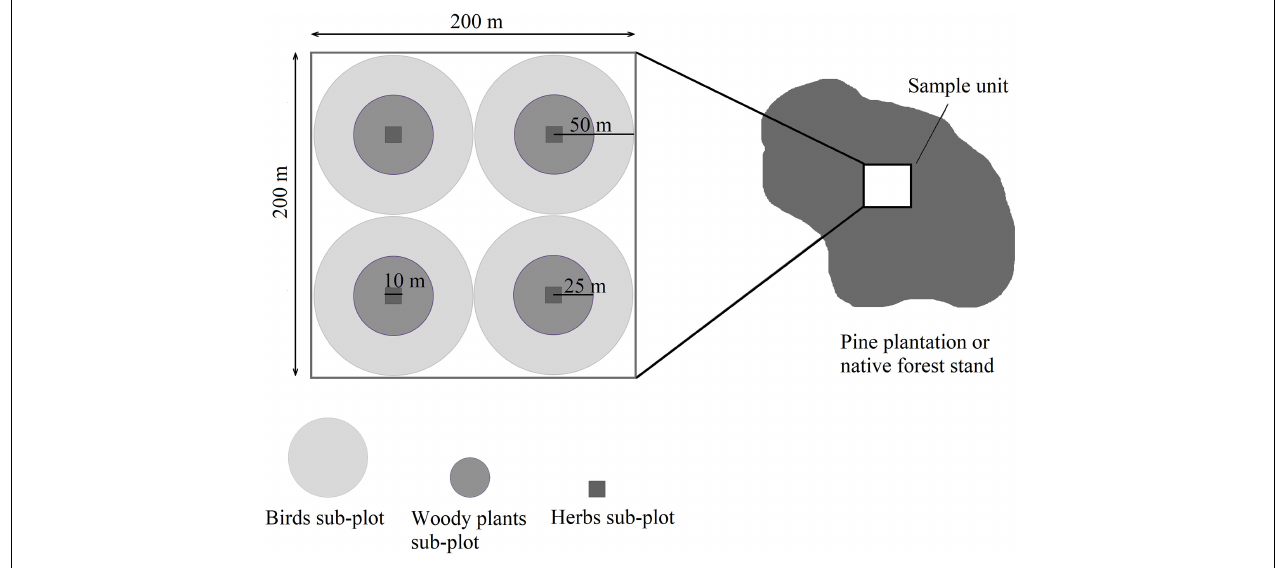
FIGURE 3 | Diagram of one sample unit, showing the sub-plots for the different studied